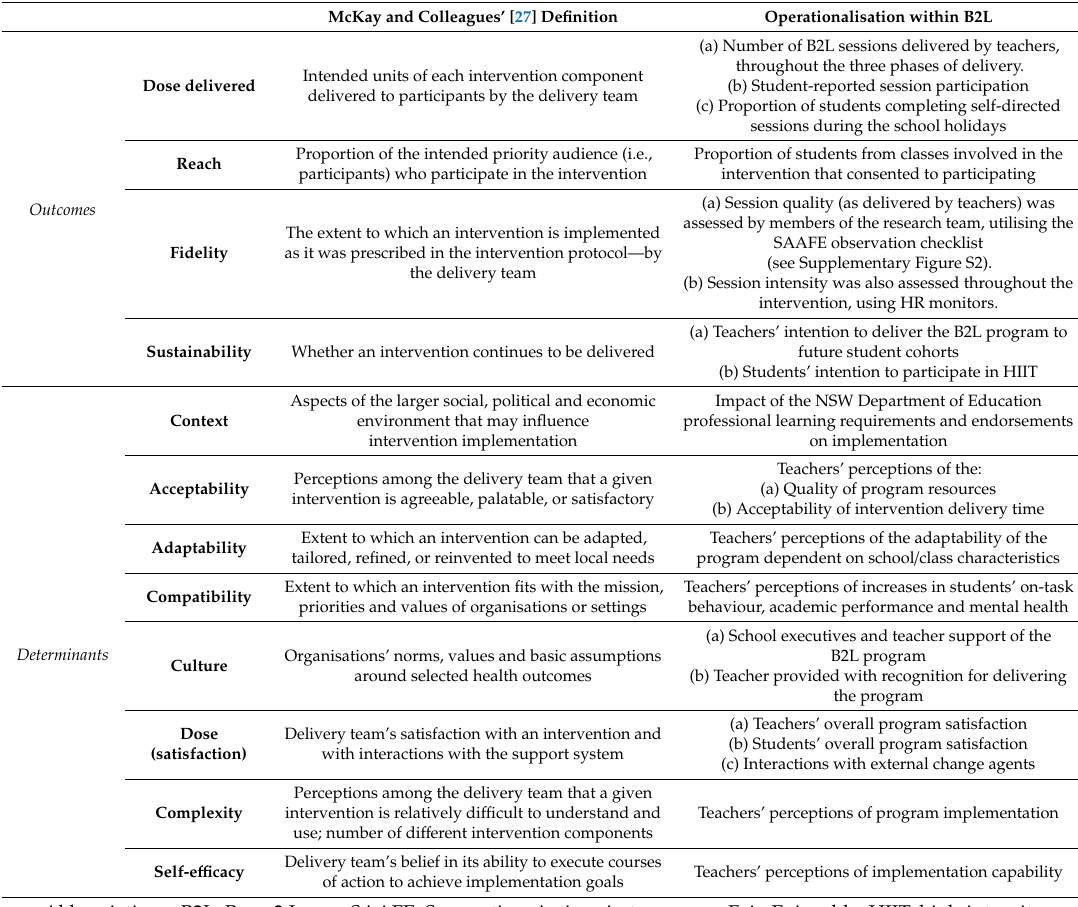
Table 1. Operationalisation of implementation outcomes and